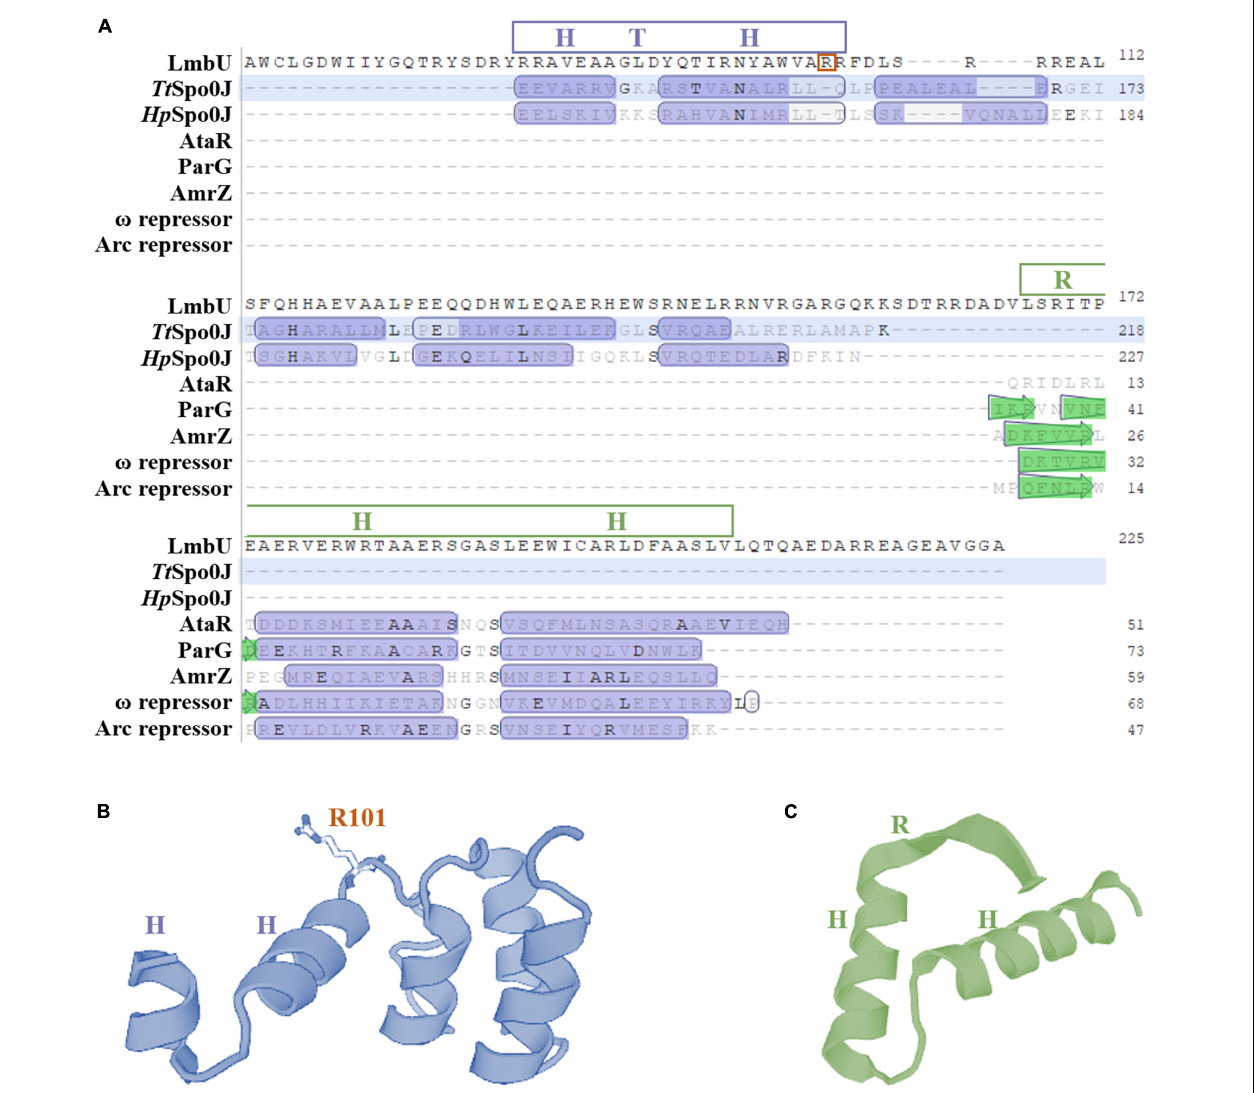
FIGURE 1 | Bioinformatics analysis of the structure of LmbU. (A) Structure based alignment of LmbU with partial structural homologs from various bacteria. Putative HTH and RHH motifs are indicated by blue and green boxes, respectively. Tt Spo0J is derived from Thermus thermophiles (GenBank accession no. WP_011173975.1), Hp Spo0J is derived from Helicobacter pylori (GenBank accession no. ACJ08256.1), ParG is derived from a multidrug resistance plasmid TP228 from E. coli (GenBank accession no. ACV89876.1), AmrZ is derived from Pseudomonas aeruginosa (GenBank accession no. APJ53923.1), ω repressor is derived from a plasmid Psm19035 from Streptococcus pyogenes (GenBank accession no. AAR27202.1), and Arc repressor is derived from Salmonella bacteriophage P22 (GenBank accession no. AAM81381.1). (B) Structural modeling of HTH motif. (C) Structural modeling of RHH motif. The results were generated by using a online software SwissModel (https://www.swissmodel.expasy.org/interactive).